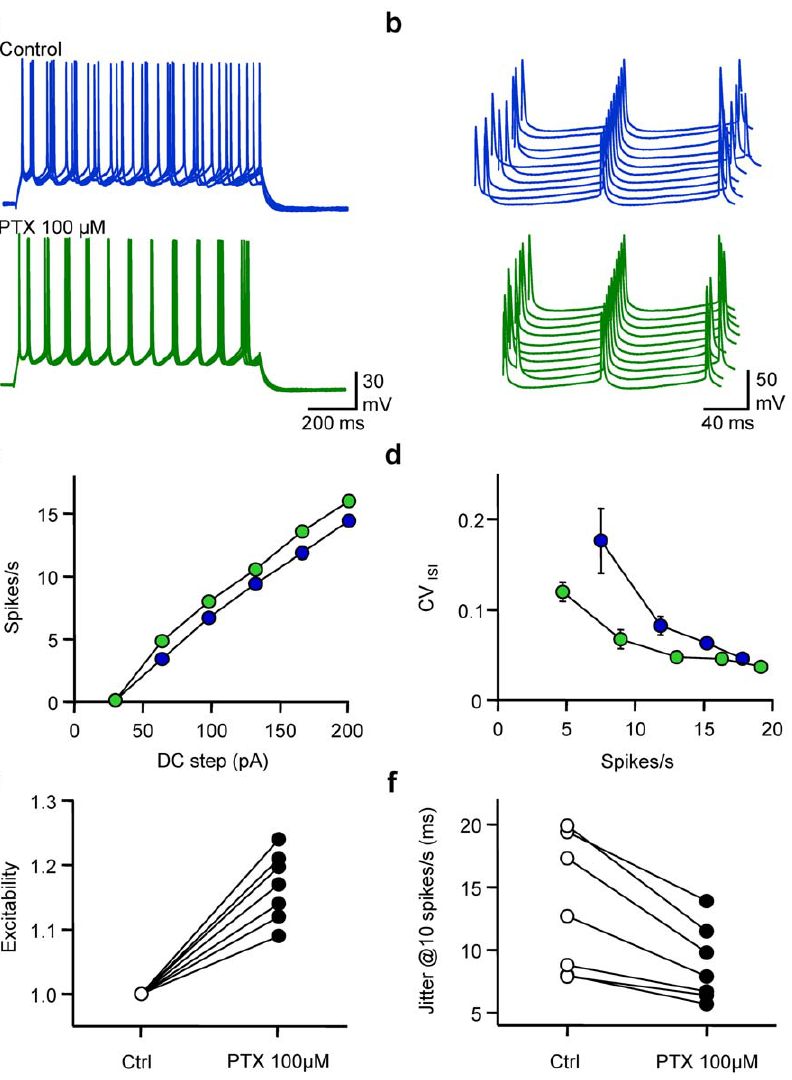
Figure 1. Spontaneous GABAergic activity affects excitability and spike timing of pyramidal cells. a, Superimposed (5) membrane potential (Vm) fluctuations of a gramicidin-perforated current-clamped L2/3 pyramidal cell in response to a DC step (1 s, 170 pA) before (control, blue) and after extracellular application of picrotoxin (100 m M, PTX, green). The cell was held at around 2 80 mV in both conditions. Same cell and colour code for b, c and d. b, Waterfall view of Vm when the 5 th spike was set as the time reference. c, Mean firing rate vs DC step. d, Coefficient of Variation of the Inter Spike Interval (CV ISI ) vs firing rate. e, Normalised changes in excitability observed when adding PTX (n=7). f, Changes in spike jitter for an interpolated firing rate of 10